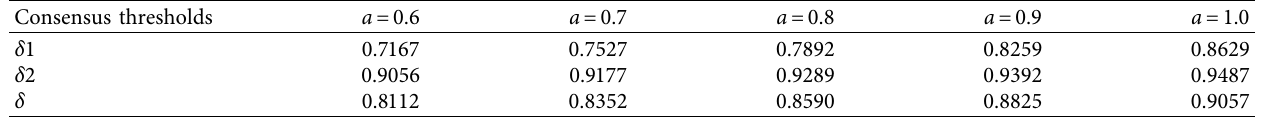
Table 23: .e consensus thresholds of the different a .